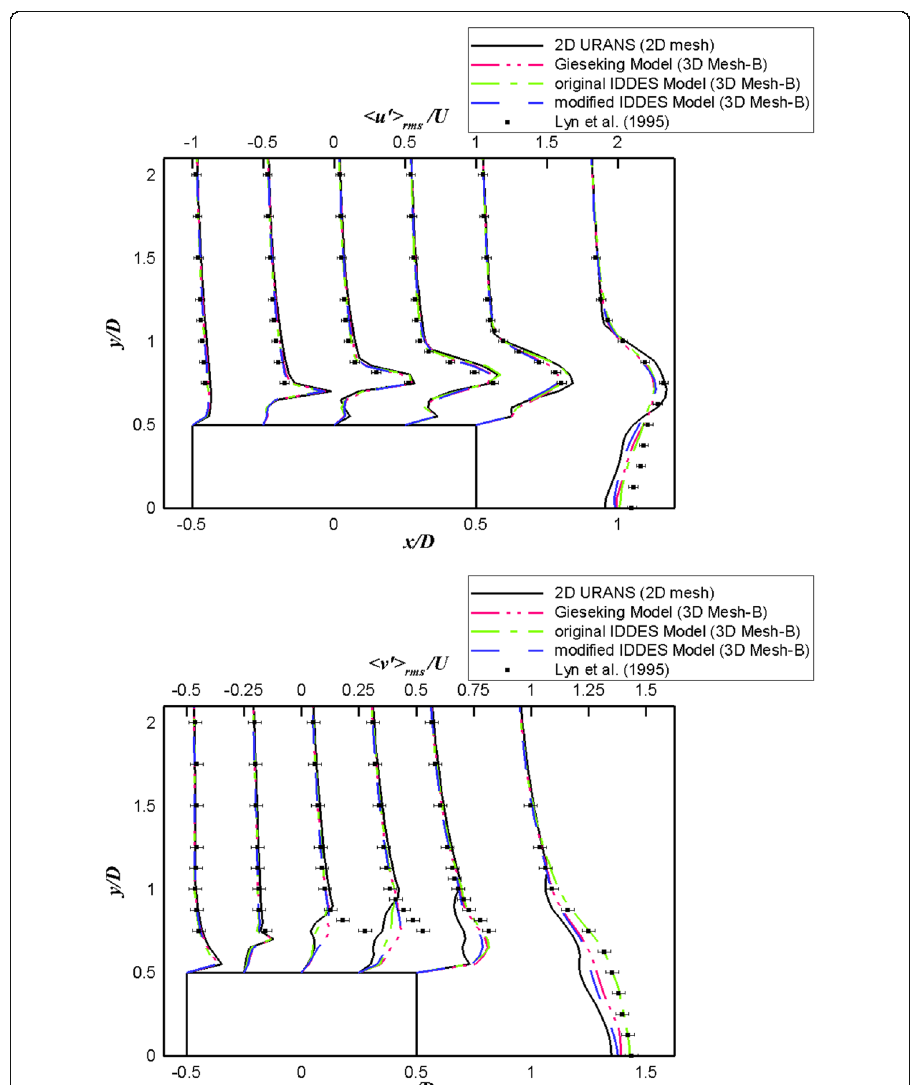
Fig. 5 rms streamwise (top) and cross-stream (bottom) velocity fluctuations at different locations before wake predicted by simulations with URANS model and 3D